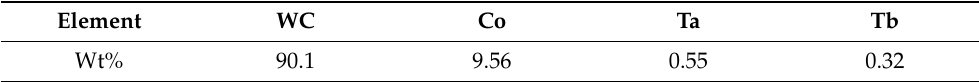
Figure 2. ( a ) Powder pressed bar before sintering, ( b ) cemented carbide sample bar after sintering. Table 2. Composition of WC/Co cemented carbide sample.